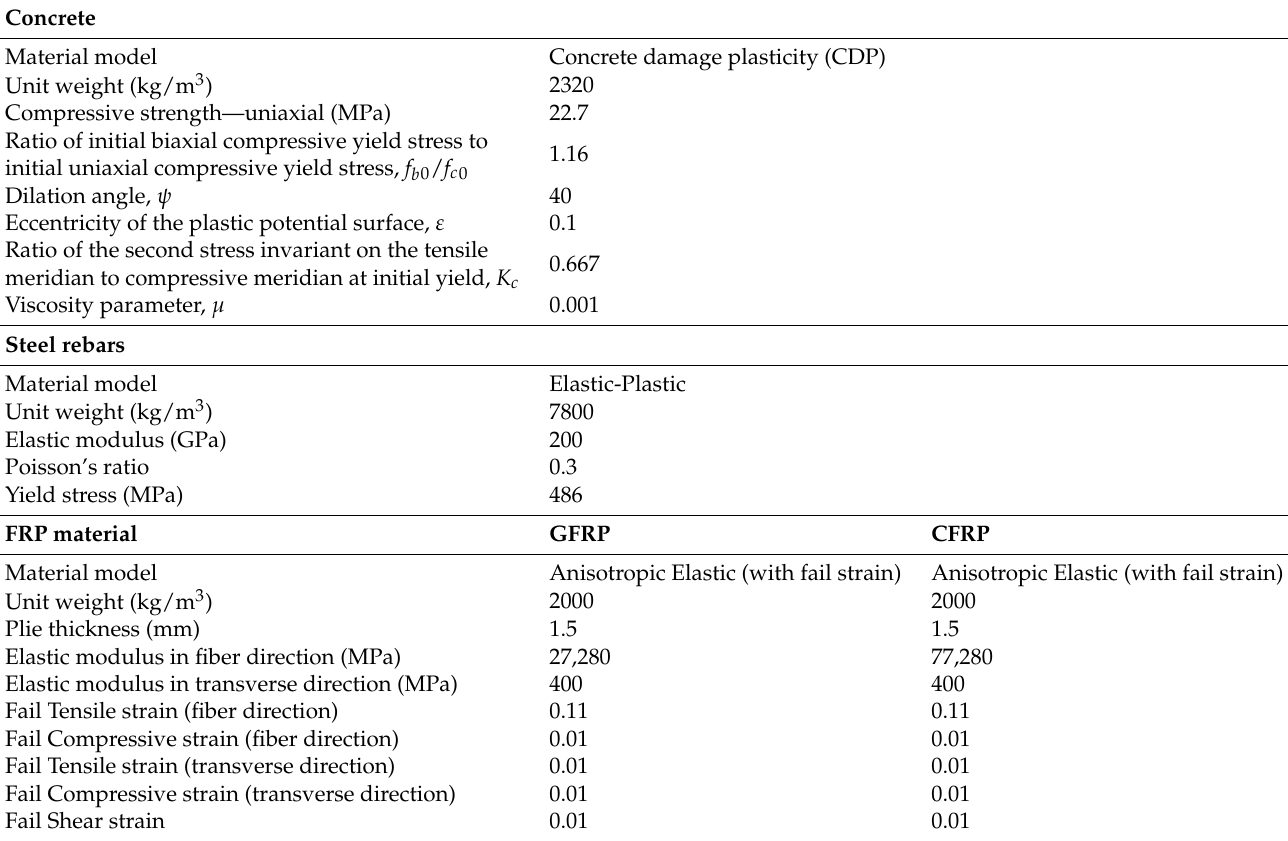
Table 4. Material properties employed in FE modelling using ABAQUS